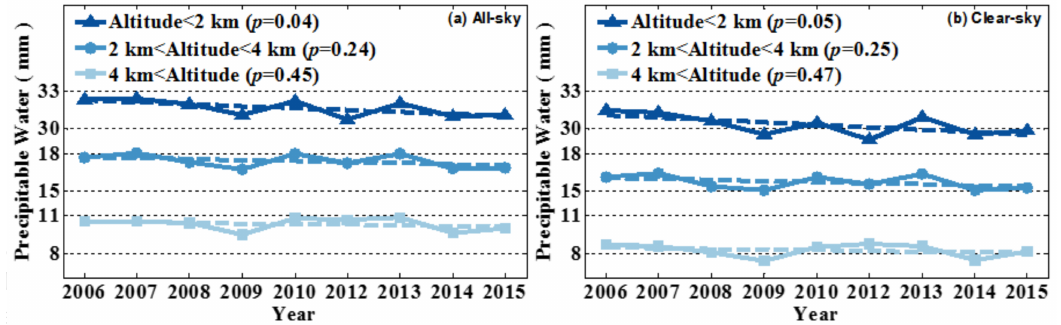
Figure 8. Temporal variations in spatial average PW in ( a ) all-sky and ( b ) clear-sky conditions at different ranges of altitude during the monsoon season in South Asia from 2006 to 2015. The dashed lines indicate the linear fit line of the solid line with the same color; p is the significance